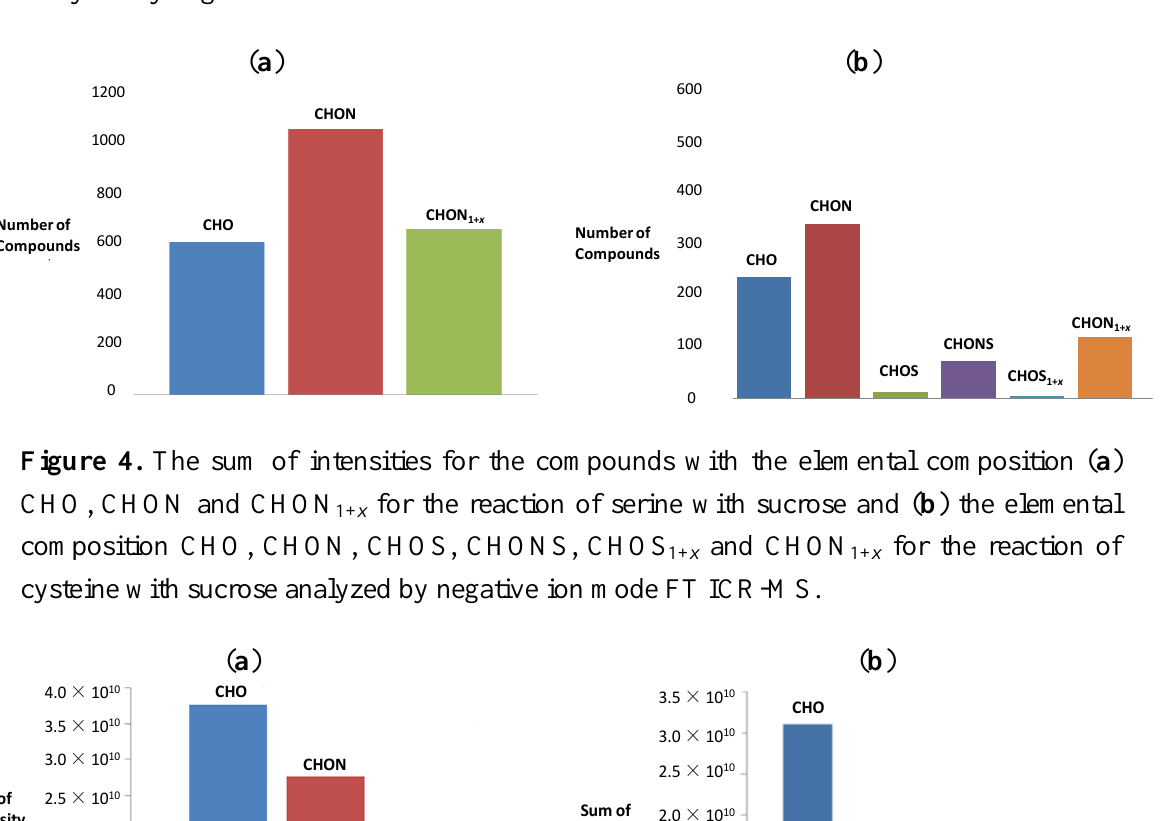
Figure 3. The number of compounds with the elemental composition ( a ) CHO, CHON and CHON for the reaction of serine with sucrose and ( b ) the elemental composition CHO, 1+ x CHON, CHOS, CHONS, CHOS and CHON for the reaction of cysteine with sucrose, 1+ x 1+ x analyzed by negative ion mode FT ICR-MS.